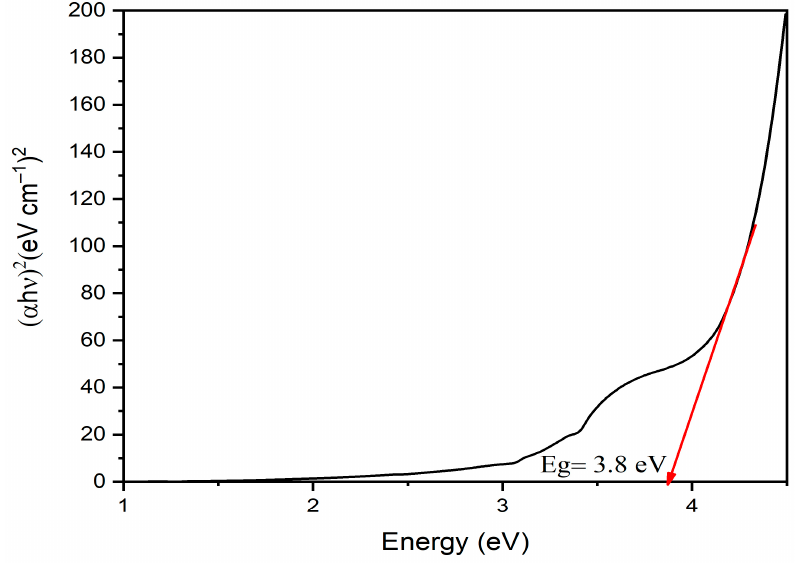
Figure 3. UV spectra of the bio-produced ZnO-NPs (Peak no 4: 242 nm; Peak no 3: 512 nm).